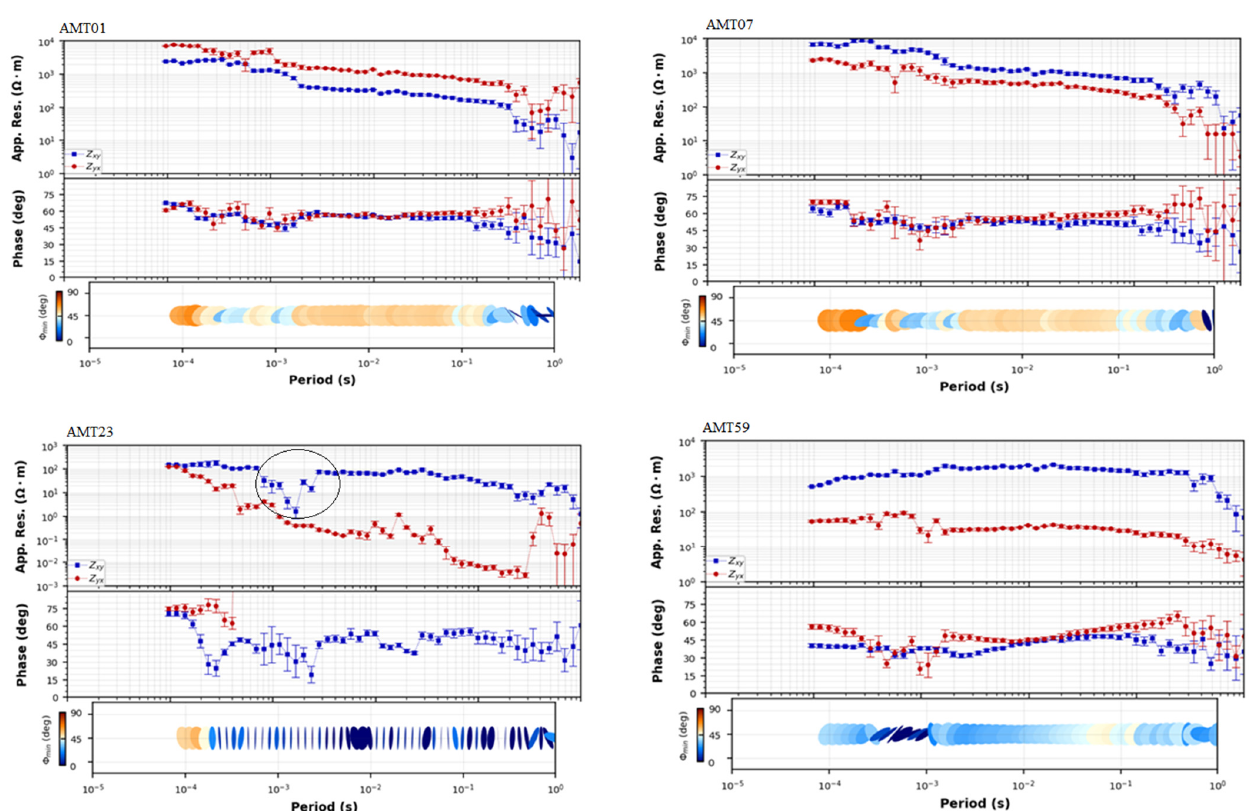
Figure 4. AMT field instruments used and the covers in the area. ICM: induction coil magnetometers.